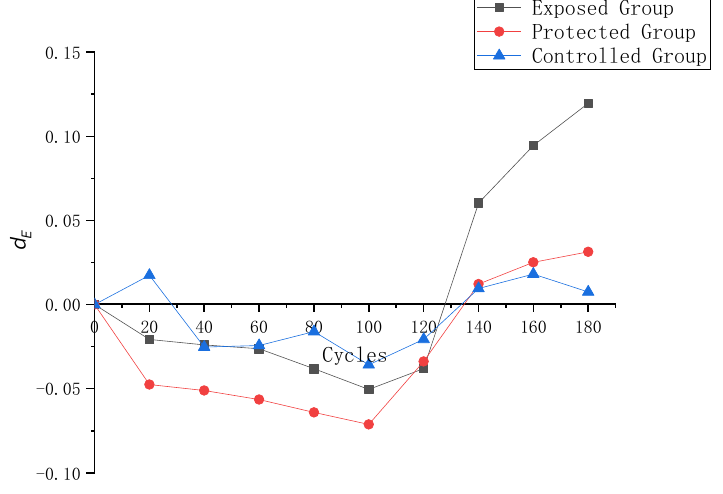
decline of the protective effect of silane coating under harsh experimental conditions. three groups of samples in the process of cyclic dry – wet erosion was calculated, and its change process is shown in Figure 7. Figure 7. Changes in d e in the process of cyclic dry–wet erosion. As can be seen from Figure 7, the variation amplitude of the dynamic mold damage to samples is from small to large: the control group, protected group, and exposed group. The dynamic elastic modulus damage to the control group samples fluctuated back and forth during the whole wet and dry cycle experiment, but the change was weak. The dynamic elastic modulus of the exposed group changes significantly. From 0 to 100 cycles, the dynamic elastic modulus damage to the exposed group decreases all the time, indicating that the dynamic elastic modulus of the sample becomes larger and larger compared to the initial state. After more than 100 dry and wet cycles, the dynamic elastic modulus loss of the sample began to increase rapidly. The dynamic elastic modulus damage to specimens in the protected group decreased to the highest level in the three groups before 100 cycles, while the dynamic elastic modulus began to increase after 100 cycles. Table 4 lists the final dynamic elastic modulus loss of samples in each group at the end of 180 dry and wet cycles. The dynamic elastic modulus damage to the control group is only 0.0075, which can be considered to be roughly equivalent to the dynamic elastic